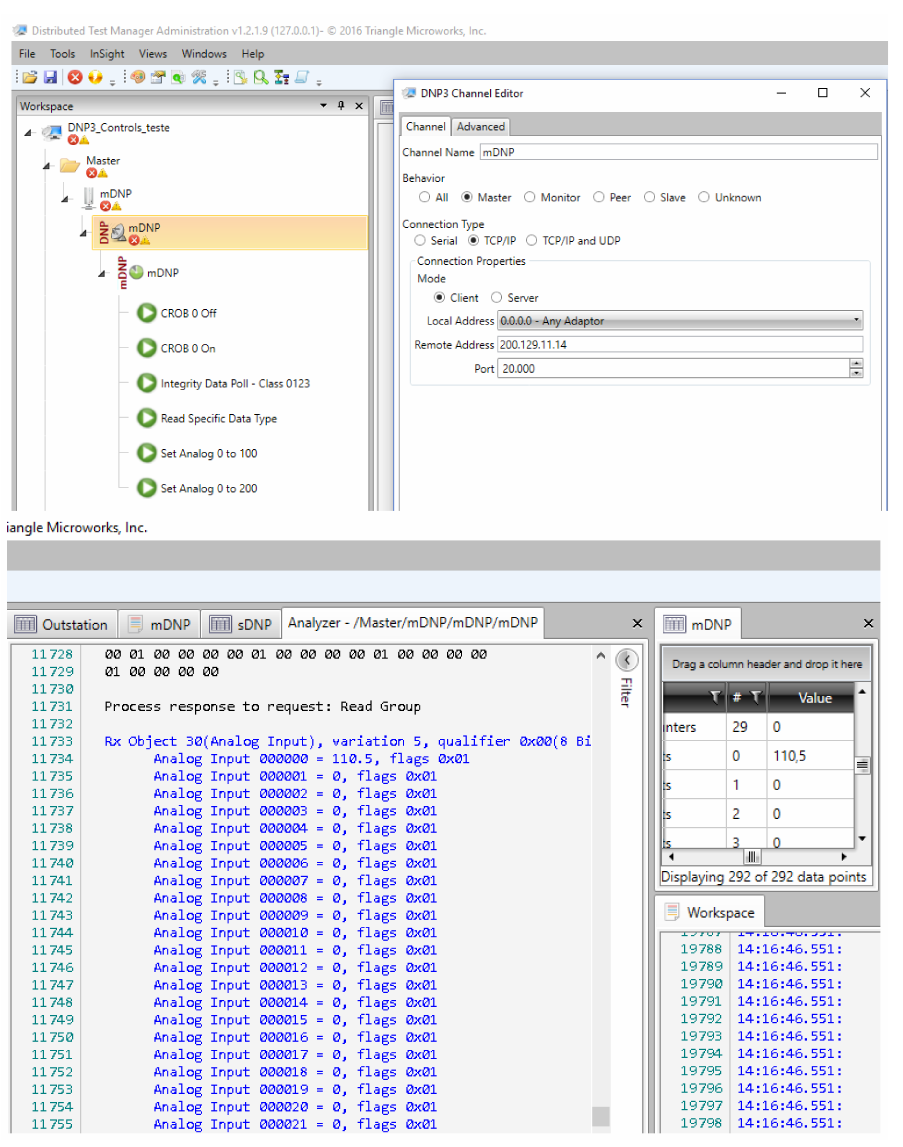
Figure 8. Screenshot of the DNP3 master configuration using DTM